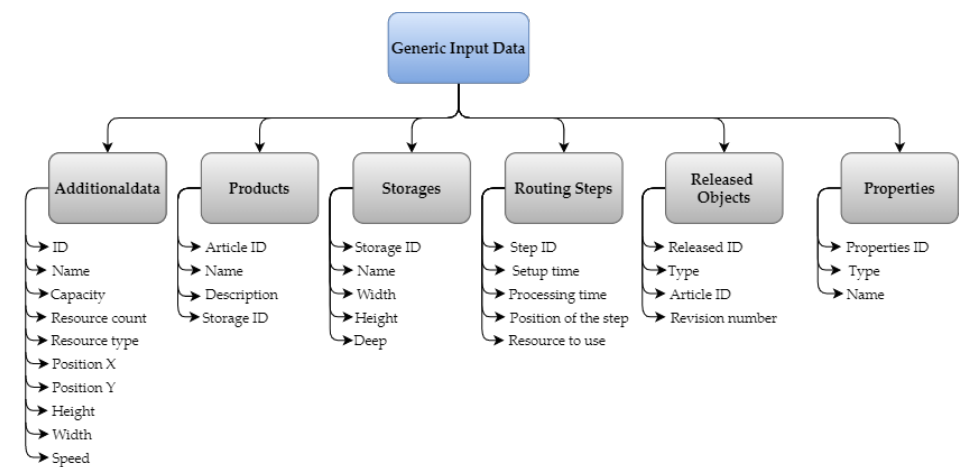
Figure 3. Generic input data for the simulation in AnyLogic TM .